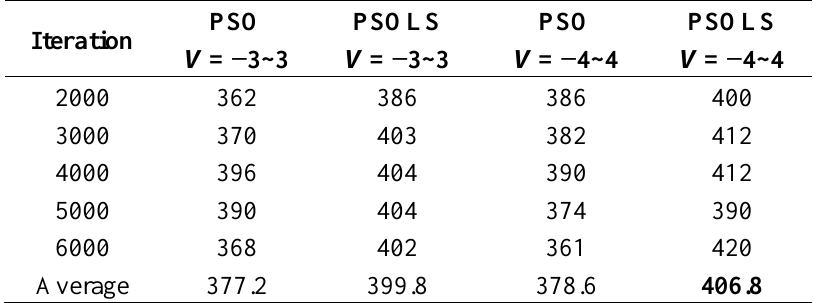
= 2, c = 2, w = 0.8). 1 2